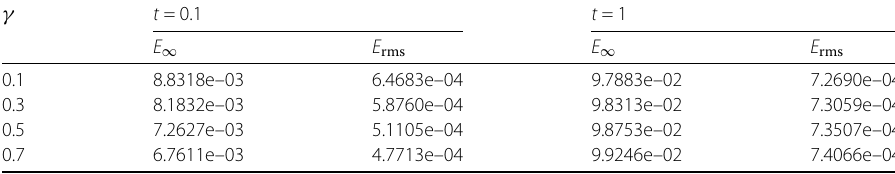
Table 7 Error norms of Example 5.4 at J = 3, θ =